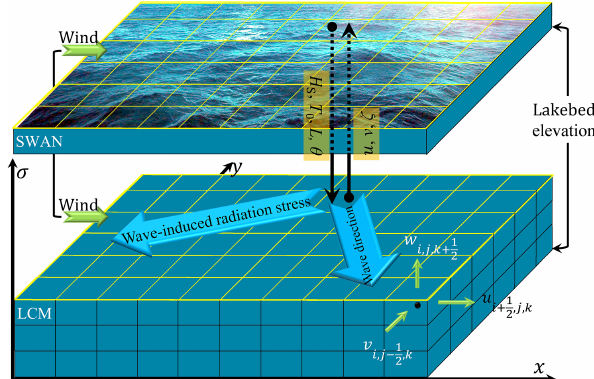
Figure 3. Structure of the Wave–Current Coupled Model (WCCM) obtained by two-way coupling SWAN and LCM models, with the variable definitions and the data transmission between the